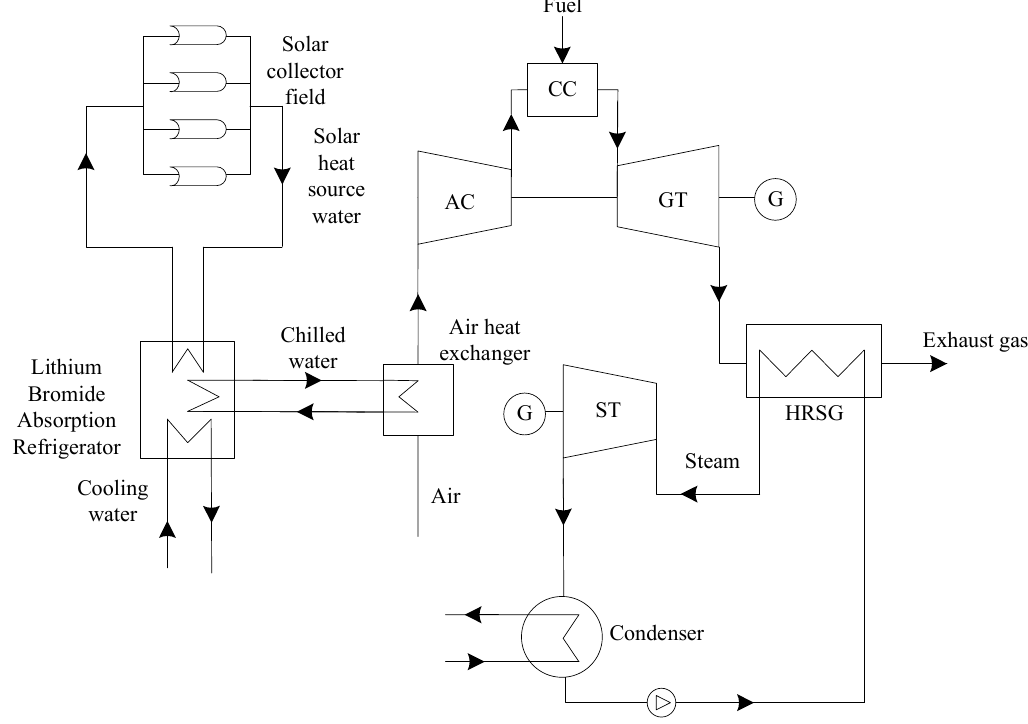
Figure 2. Solar-driven single effect Li-Br absorption refrigeration integrated into gas turbine combined cycle ( GTCC). cycle